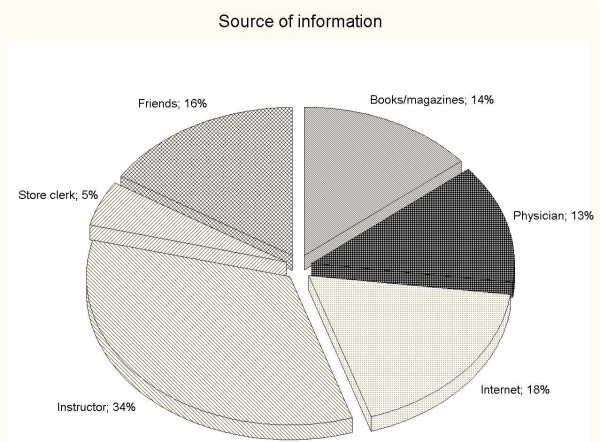
Source of information about use of supplements. Distribution of source of information amongst users.